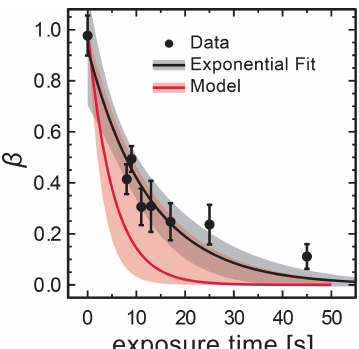
Figure 7. Loss of Fe III in Fe III ( Cit )/ CA (molar ratio of 1) particles as a function of light exposure time determined using STXM/NEXAFS at 293.5K. Each data point is the average Fe III fraction over about 16–36 individual particles. An exponential fit, β = β 0 e j obs t , yields for the initial condition β 0 = 0 . 93 ± 0 . 09 and a first-order decay rate of j obs = 0 . 08 ± 0 . 01s − 1 . The black shad- ing indicates 95% confidence on the exponential fit. The PRAD model prediction and uncertainty are given as red solid line and shading, respectively, and use a calculated decay rate of j calc = 0 . 20 ± 0 . 12s − 1